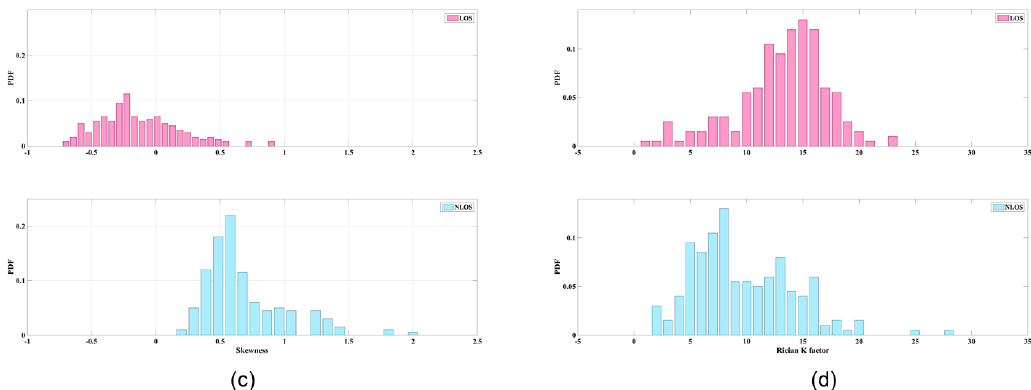
Figure 2. The feature demonstrations of the LOS/NLOS signal, ( a ) mean value; ( b ) Kurtosis value; ( c ) Skewness value; ( d ) Rician K